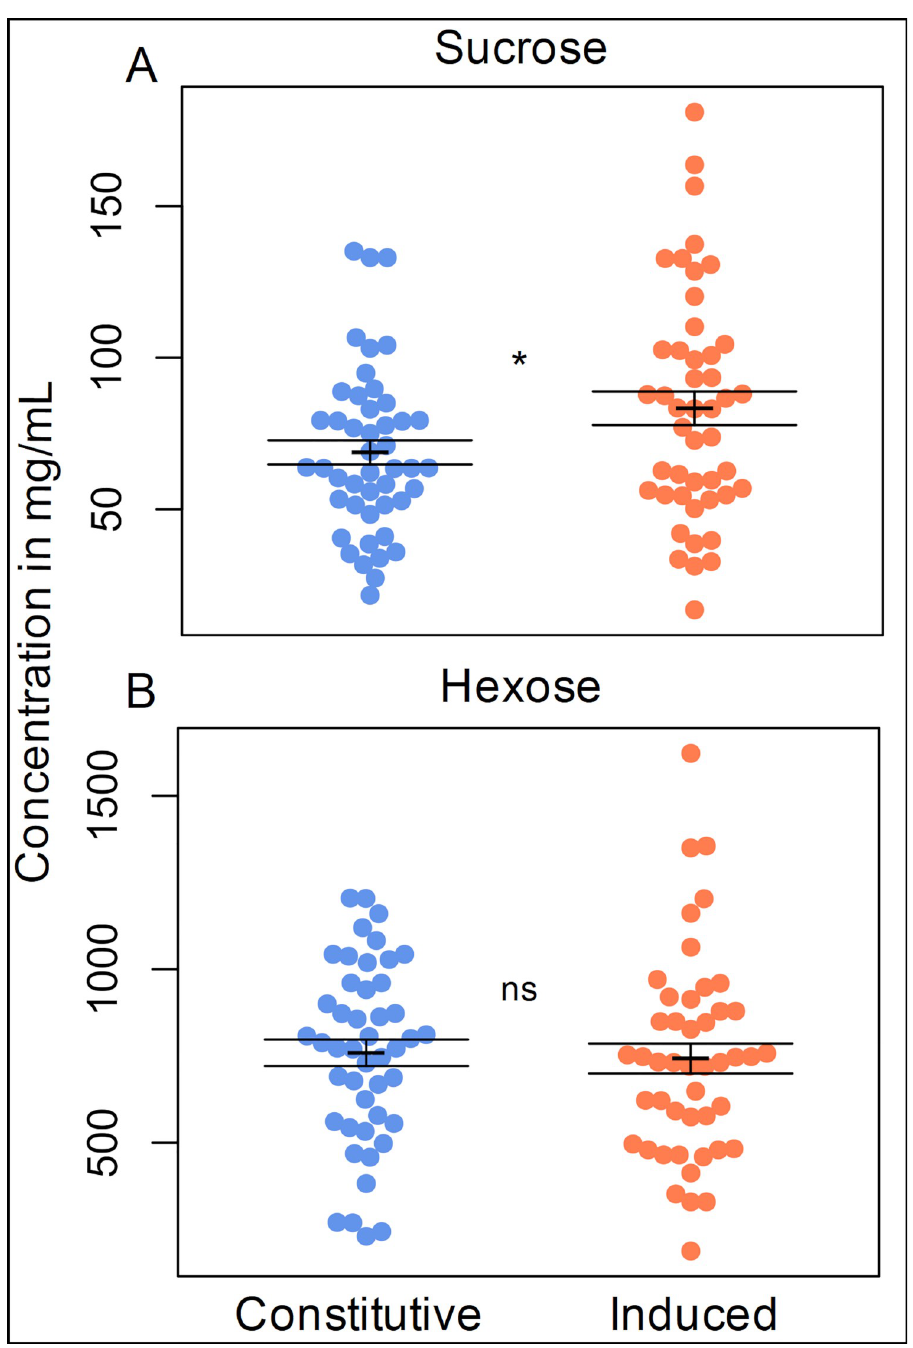
Fig 4. Carbohydrate composition of G . hirsutum EF nectar. (A) Sucrose and (B) Hexose (total glucose and fructose) concentrations in bracteal EF nectar when herbivores were absent (constitutive) or present (induced). Sucrose concentration increased from an average of 69 mg/mL in constitutive samples to 83 mg/mL in induced samples. Means ± 1 SE shown with black brackets. � = significantly different, ns = not significantly different at α = 0.05.